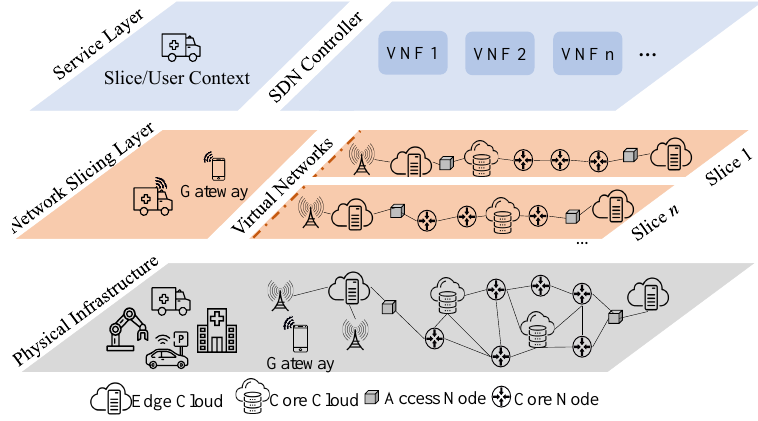
Figure 1. An overview of network